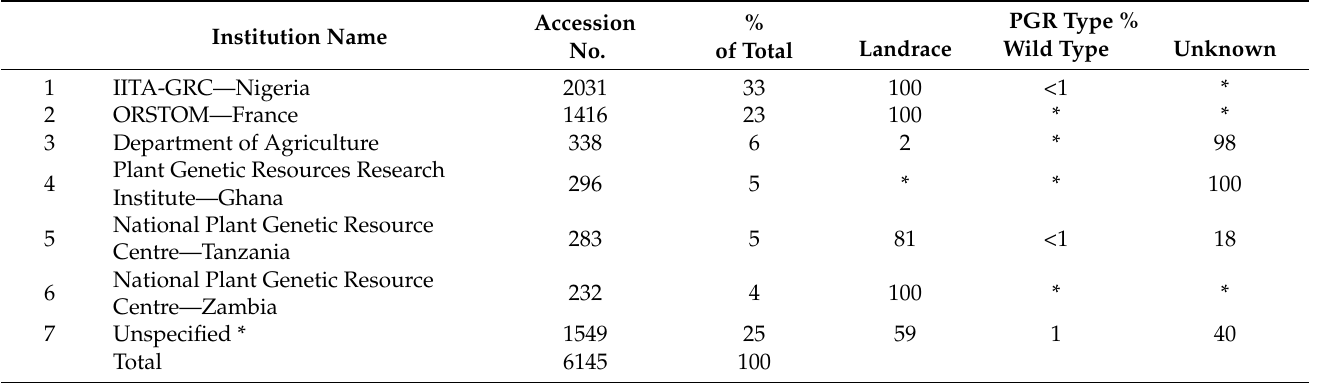
Table 1. Plant genetic resources of bambara groundnut held in various genebanks .